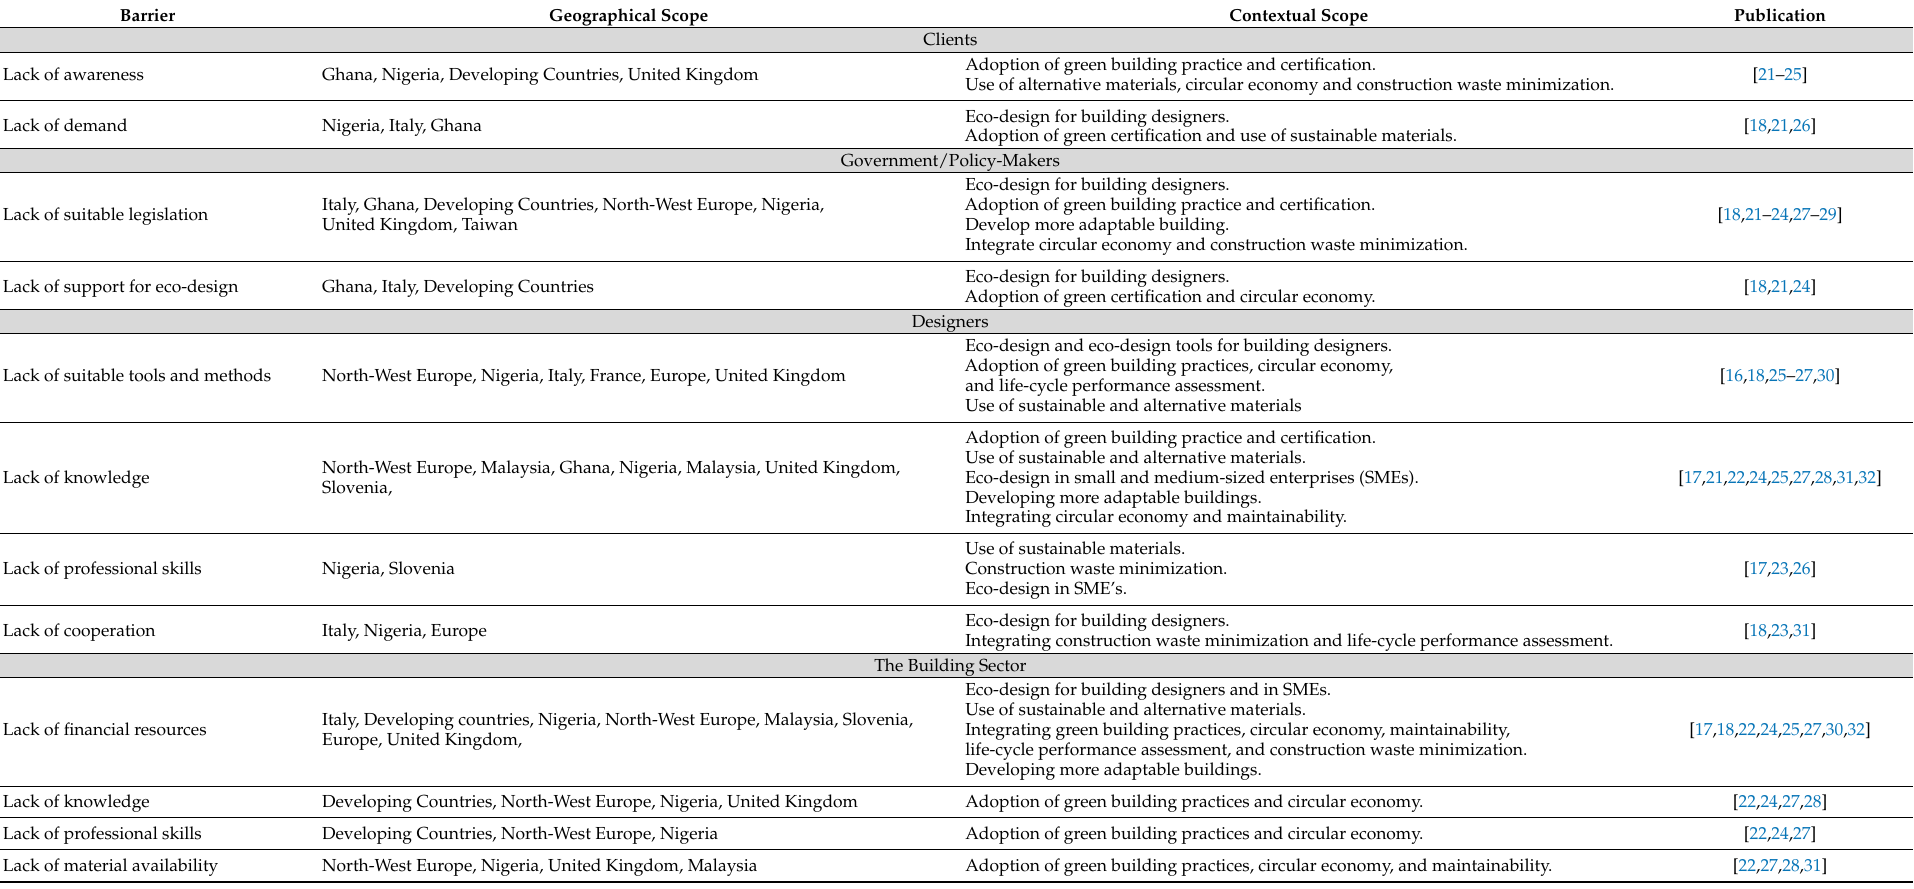
Table 1. Barriers to implementing eco-design in the building sector based on reviewed literature divided into their respective stakeholder